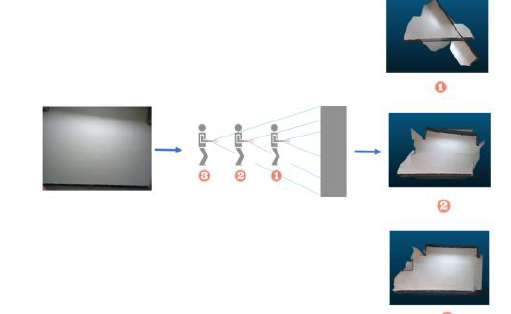
Figure 2. Comparison of results from different acquisition positions.